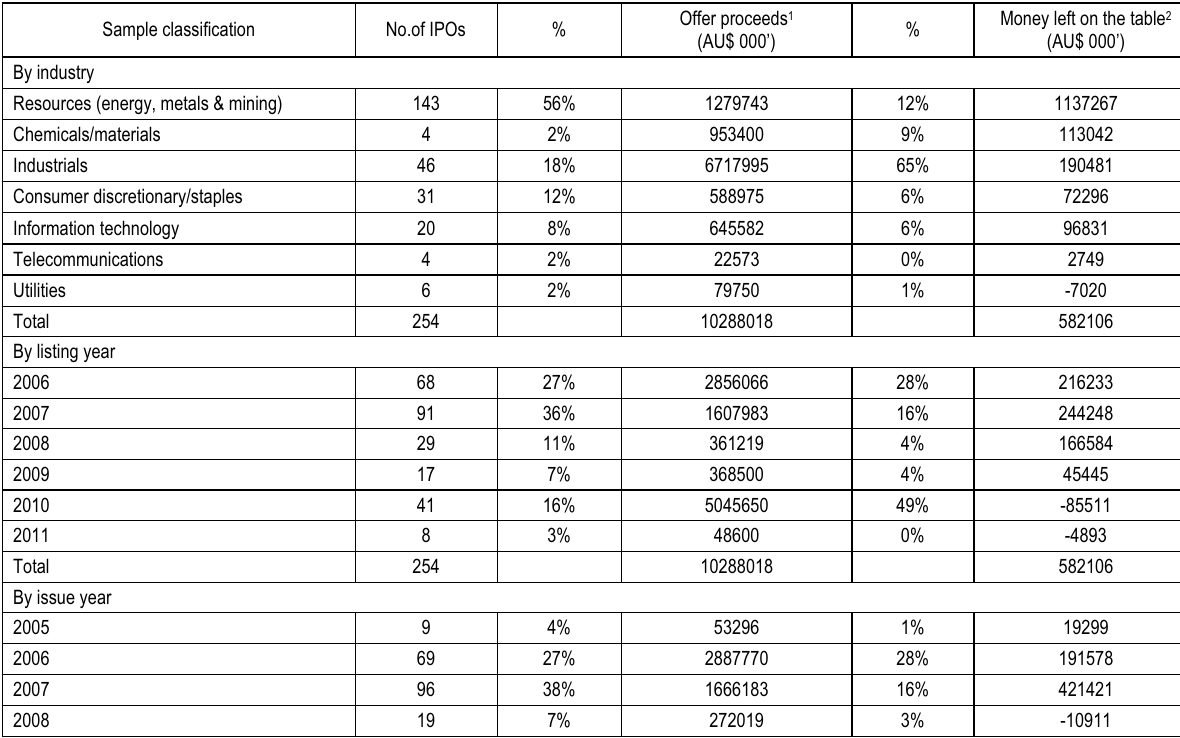
Table 2. Number of sample companies, offer proceeds and money left on the table by industry, listing